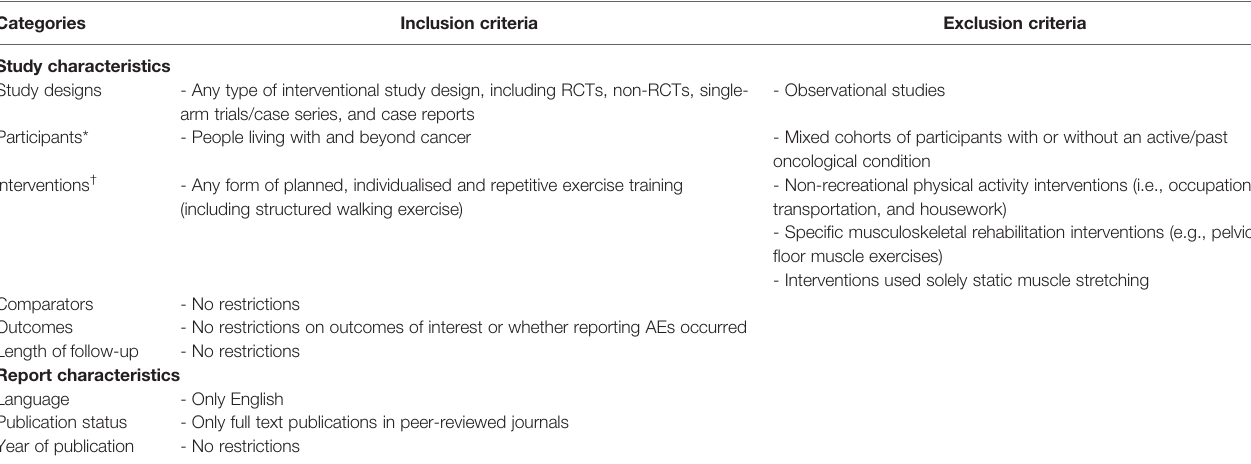
TABLE 1 | An overview of eligibility